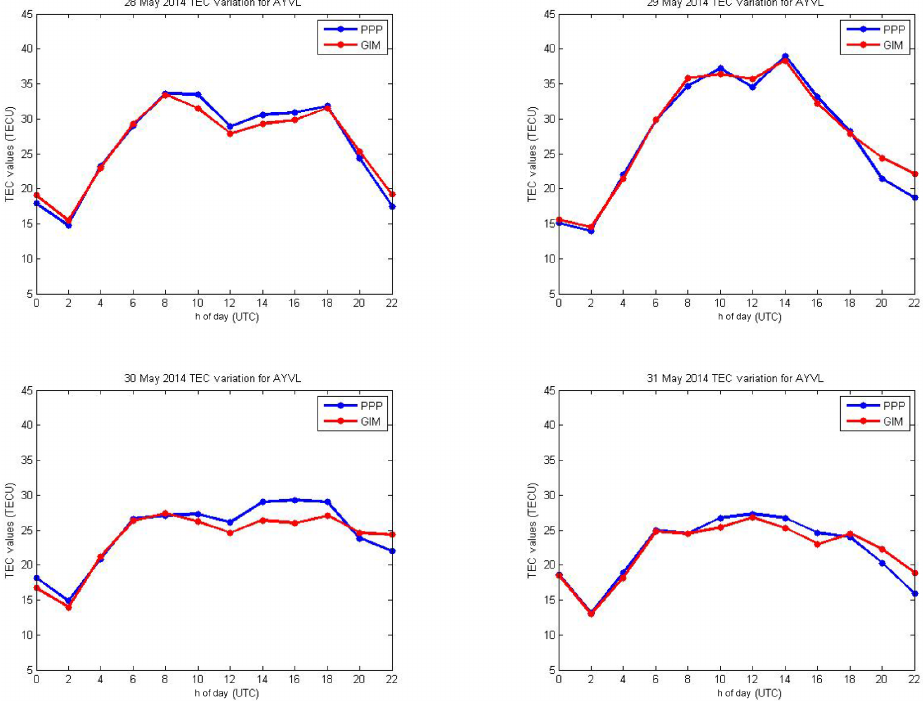
Figure 5. Representation of PPP and GIM-TEC values for the AYVL station. Table 1. PPP-TEC and GIM-TEC maximum and minimum values representation. Stations Minimum (PPP-TEC) Maximum (PPP-TEC) Minimum (GIM-TEC) Maximum (GIM-TEC) TECU TECU TECU TECU AYVL 10.6 41.5 13.1 44.3 CANA 12.1 44.1 10.2 39.7 IPSA 13.0 43.1 10.6 39.8 YENC 13.1 44.4 10.4